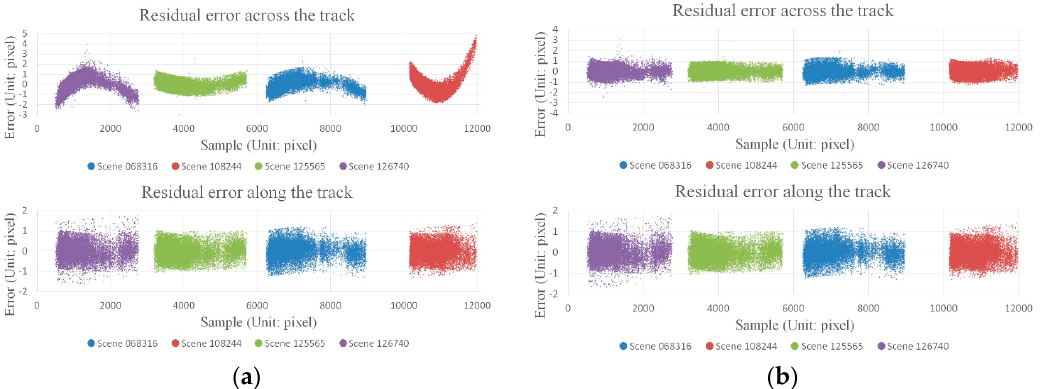
Figure 5. Residual errors ( a ) before; and ( b ) after compensation for distortion (horizontal axis denotes the image row across the track and vertical axis denotes residual errors after orientation).